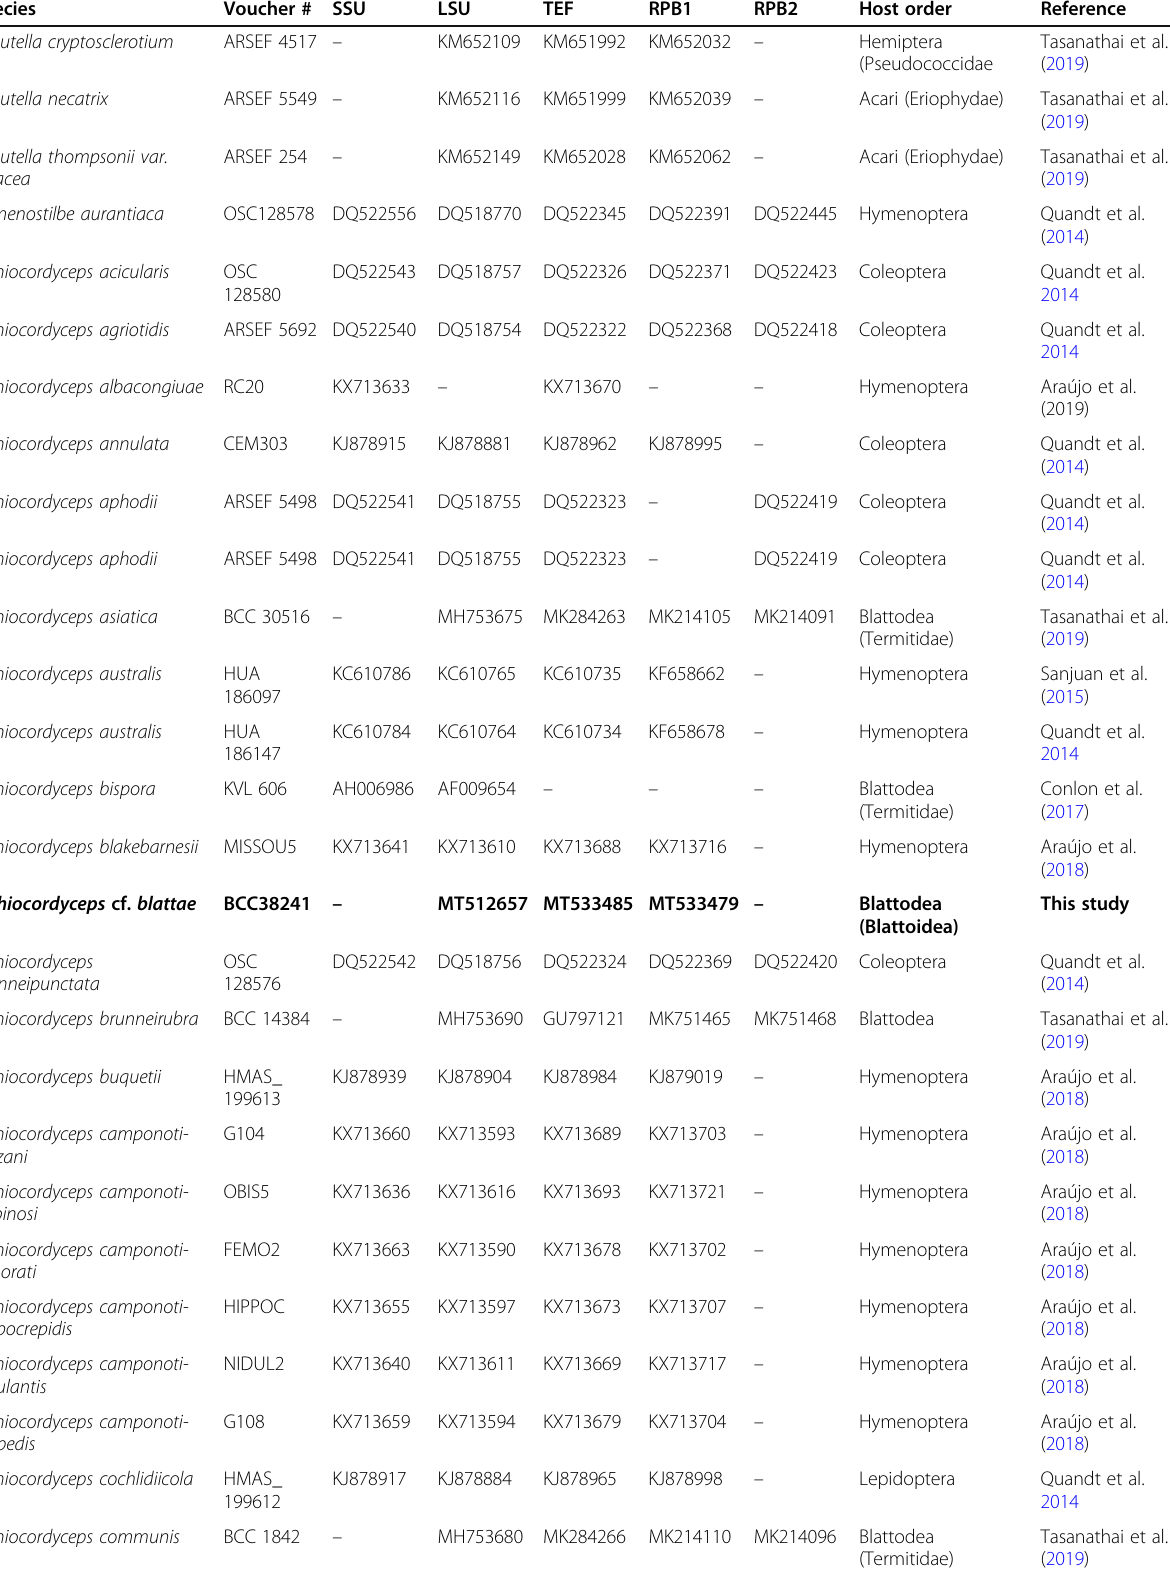
Table 3 Genbank accession number, host association and reference for all Ophiocordyceps species used in this study